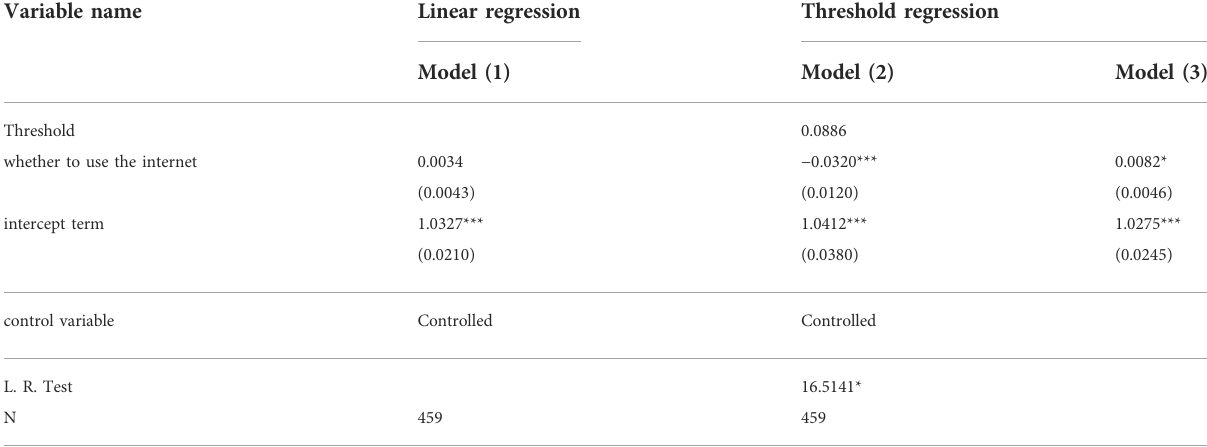
TABLE 6 Estimation results of threshold